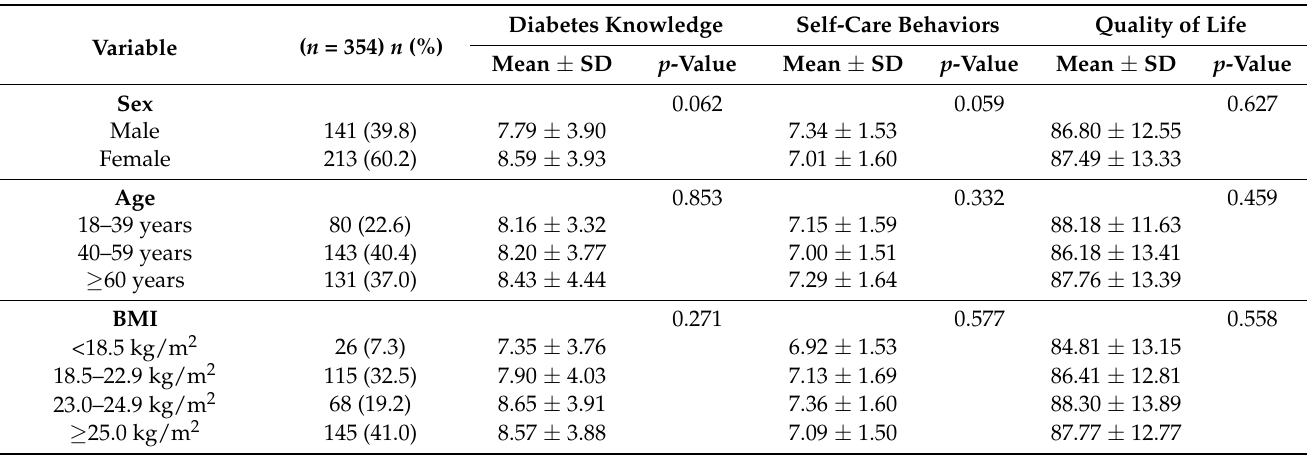
Table 2. Factors of family caregivers that related to elderly diabetic patients’ diabetes knowledge, self-care behavior and QoL ( n =